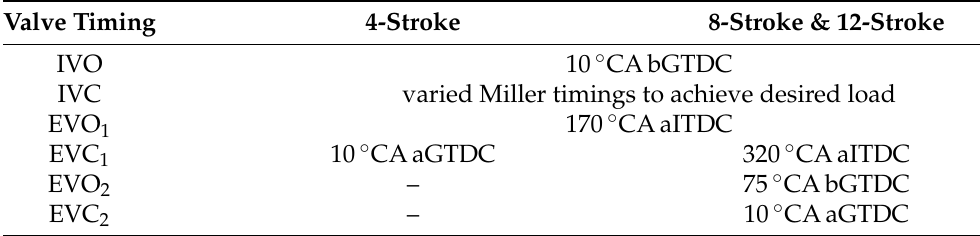
Table 6. Valve timings for load variation with different stroke